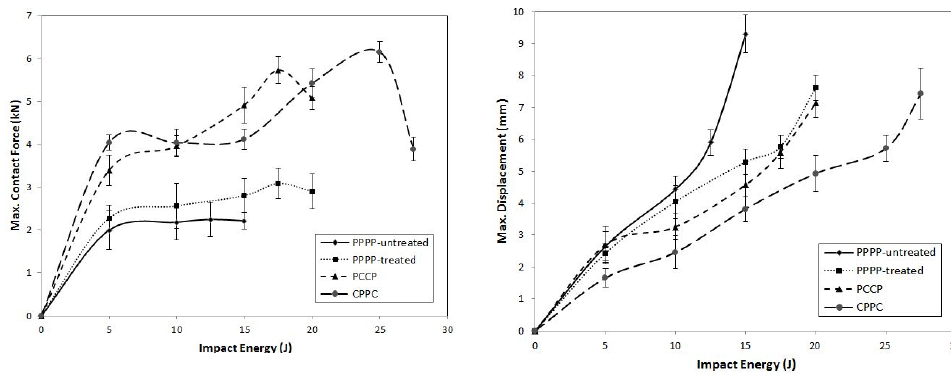
Figure 11. Maximum contact force and displacement against impact energy of the hybrid laminates at ply orientations of [±45° 2 , 0°/90° 2 ] s .